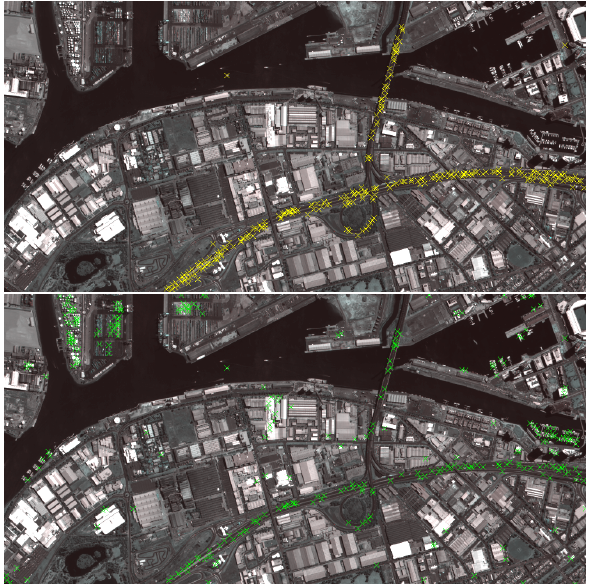
Figure 24: Example Pl´eiades image, 4 × 2 km 2 , harbour of Mel- bourne (Australia), top: reference of manually measured cars (yellow crosses), bottom: automatically found moving objects (green